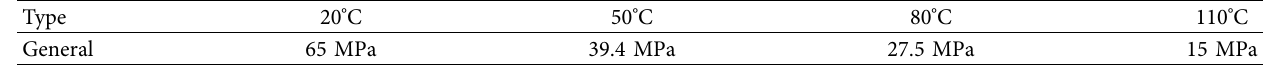
Table 2: Compressive strength of the anchoring agent in different temperature environments.